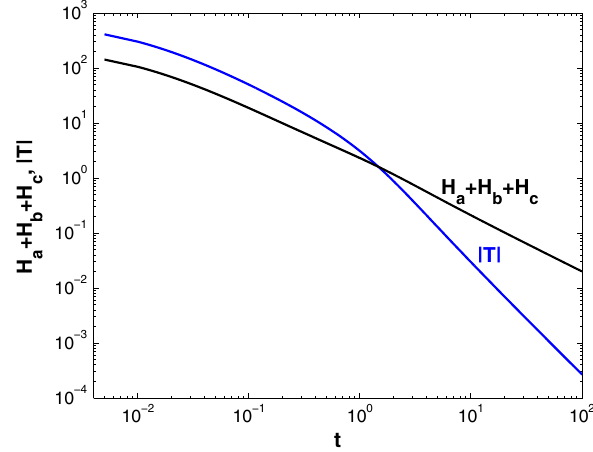
Fig. 3 Theevolutionofthetorsionscalar | T | andthesumoftheHubble parameters X = H a + H b + H c for N = 2, f 0 = − 1 , w = 0, K = 1. 12 The initial values are H a ( 0 ) = 220, H b ( 0 ) = − 10, H c ( 0 ) = 12. This figure demonstrates the cosmological scenario IIa , where the Universe evolves from the anisotropic solution of point 1 to the isotropic regime of the point 3 ( T ) point where f T = df